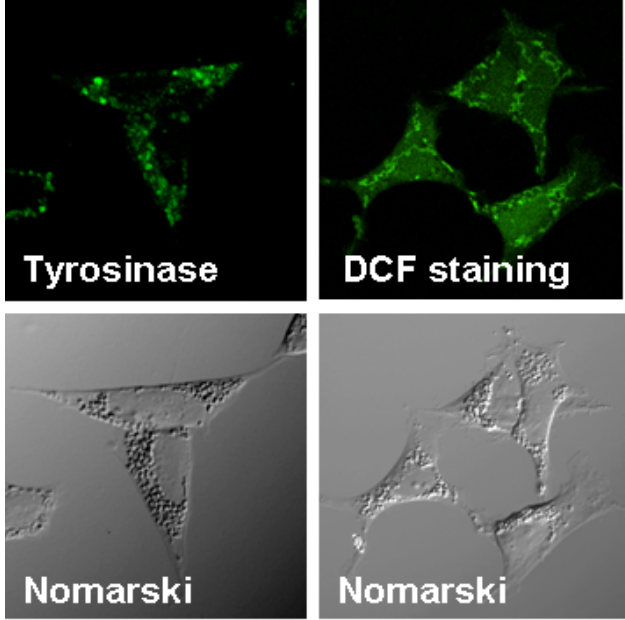
Figure 2. Inducible expression of human tyrosinase in SH-SY5Y cell. Immunohistochemical staining of SH-SY5Y cell line expressing tyrosinase under tetracycline regulatable promoter. At 72 hrs after the induction with doxycycline (1 g/mL), dispersed cytoplasmic tyrosinase protein (green) had accumulated in cytoplasmic particles, which were co-localized with rounded, pigmented bodies mimicking the neuromelanin granules. Intracellular ROS production was visualized by ROS indicator DCFH (green